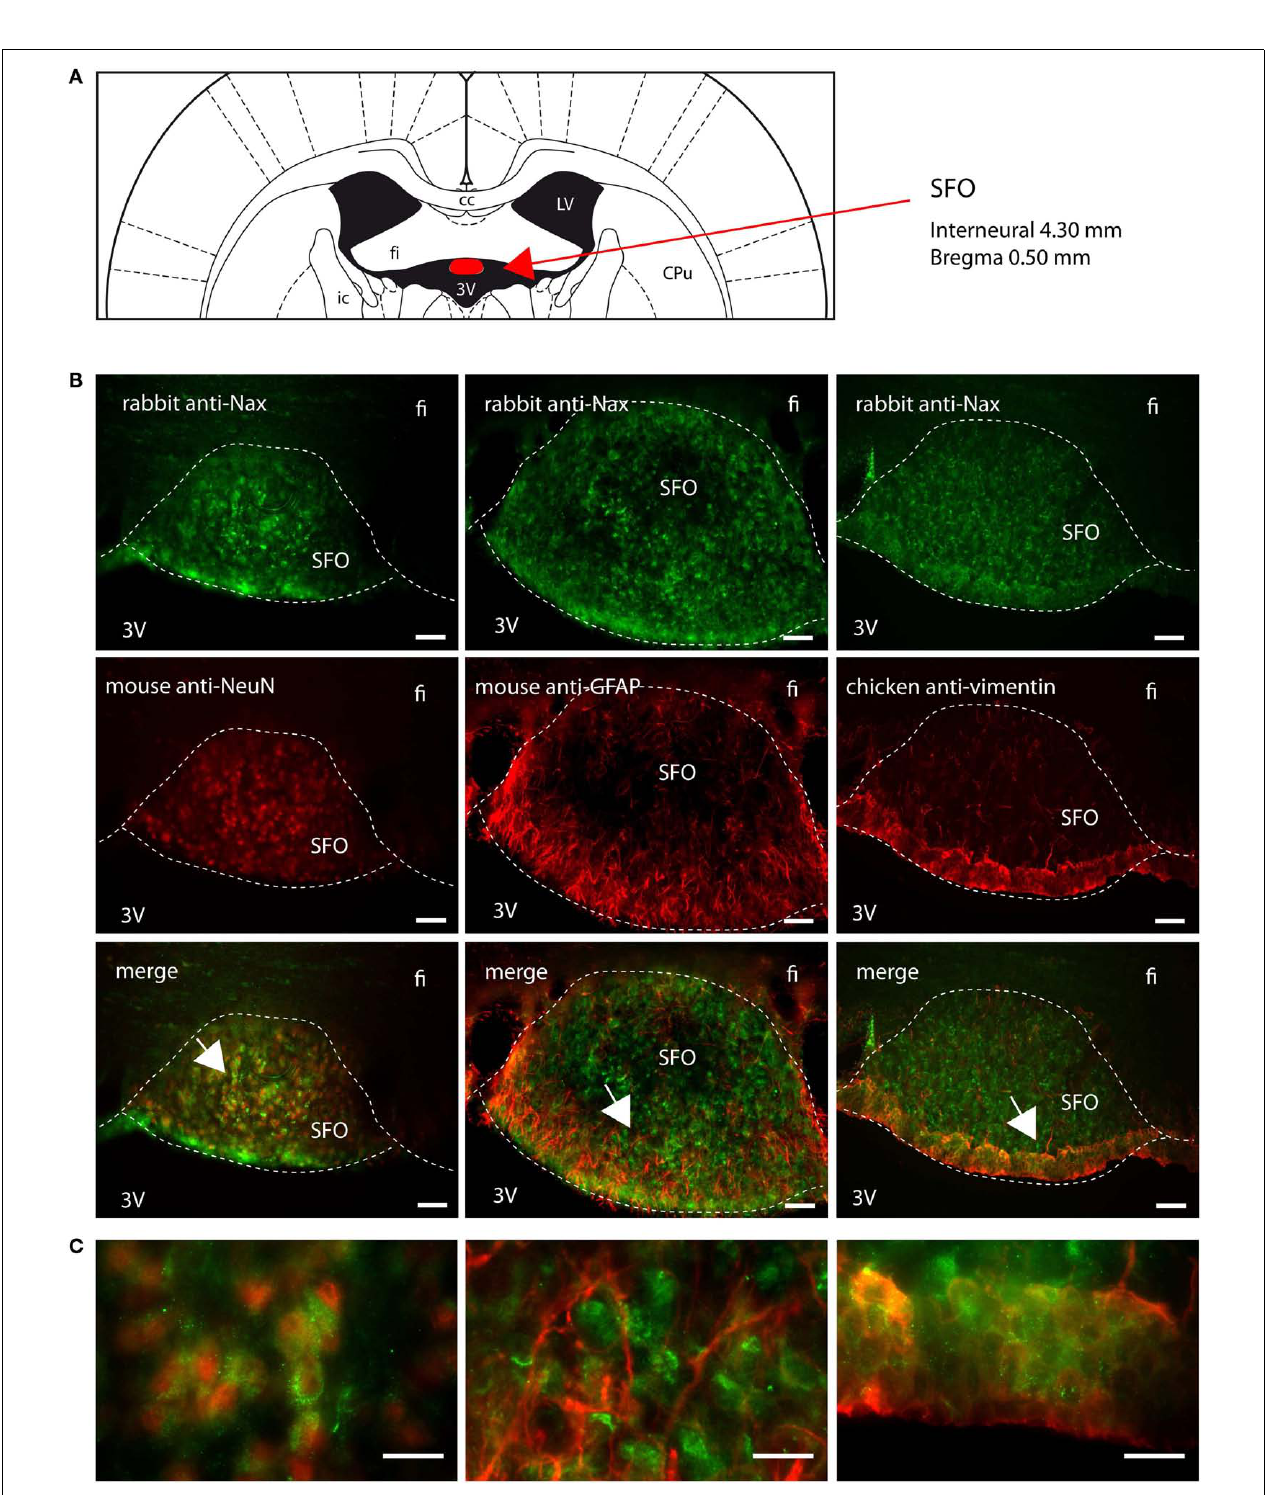
Na X was identified using anti-NeuN, anti-GFAP, and anti-vimentin fluorescent immunostaining (red); scale bars: 50 µ m. (C) Inset representing high magnification area of the SFO; scale bar: 20 µ m.The enlarged zone is pointed by the arrow head (top-left corner of the inset). Na X staining is present in NeuN positive cells in the core of the SFO and in vimentin positive cells in the cell layer boarding the third